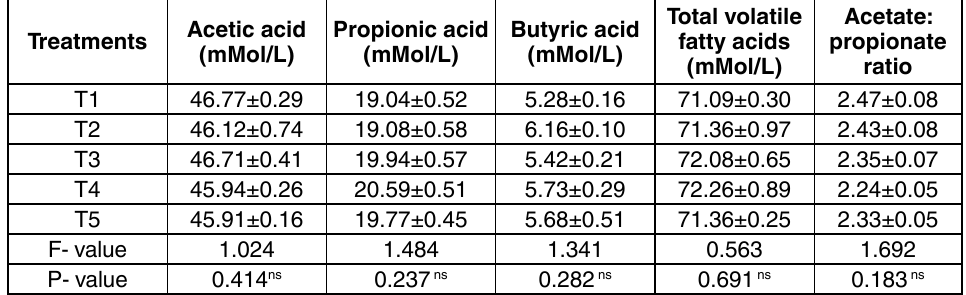
Table 4. Volatile fatty acid concentration 1 of TMR supplemented with biotin in cross bred cows assessed in